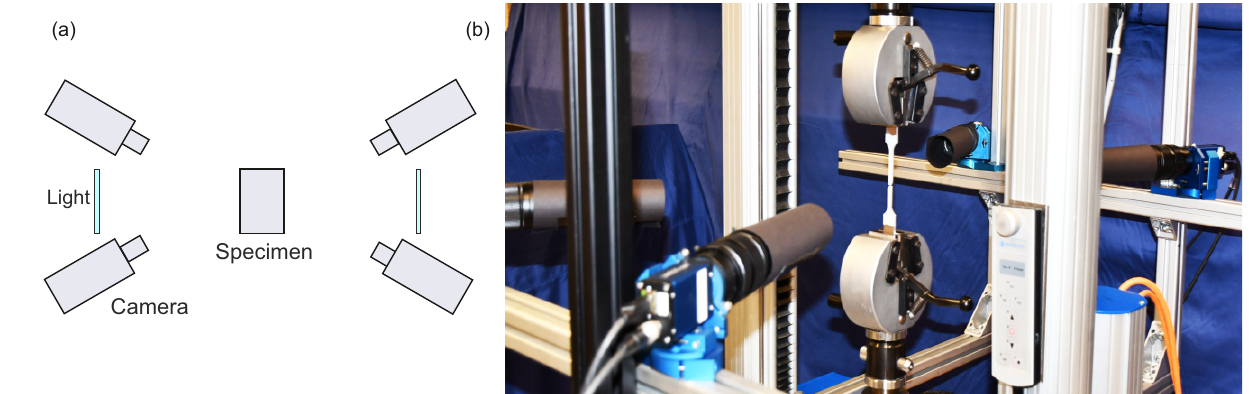
Figure 1. View of ( a ) schematic draw and ( b ) experimental setup for the tensile tests.